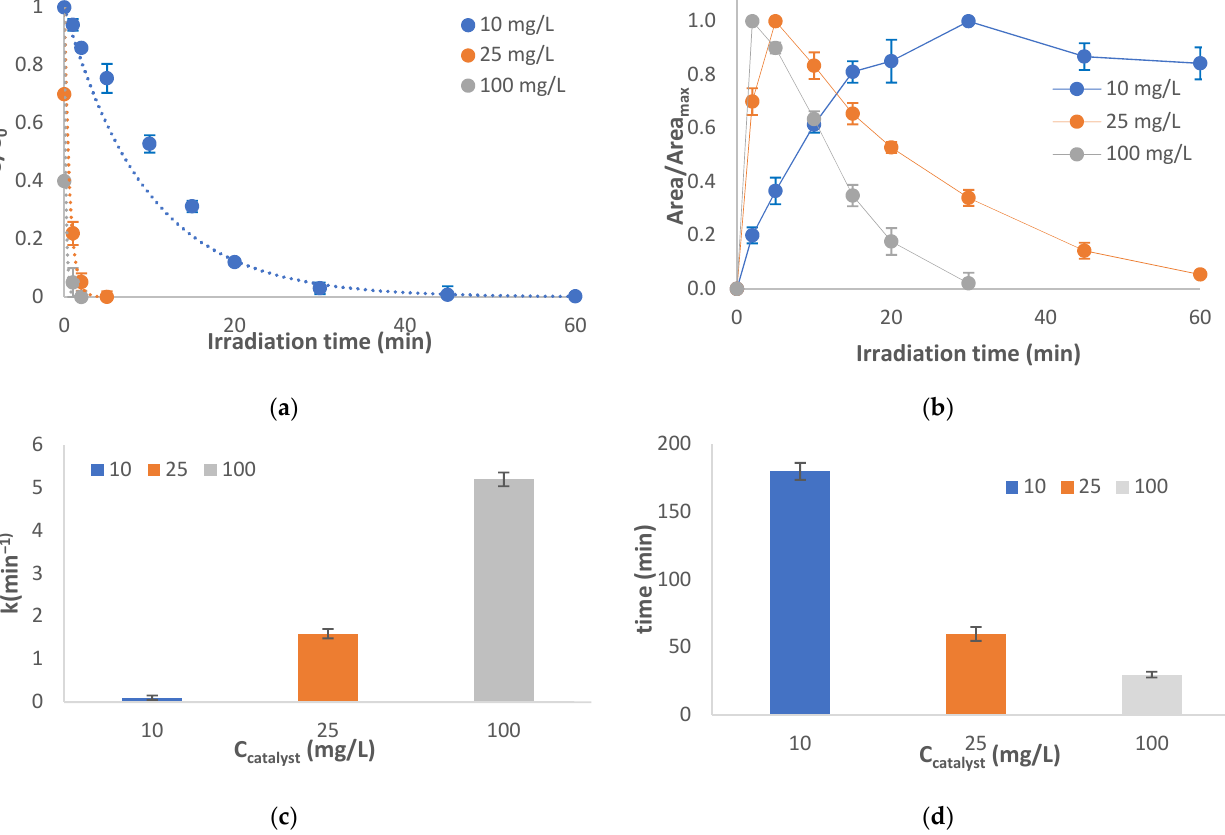
Figure 2. Photocatalytic treatment under different concentrations of catalyst: ( a ) degradation of the parent compound, ( b ) evolution profile of TP-247, ( c ) rate constant of the degradation of abacavir, ( d ) time required for complete disappearance of TP-247. C 0 = 10 mg/L, C TiO2 =10, 25 or 100 mg/L, matrix = ultrapure water.